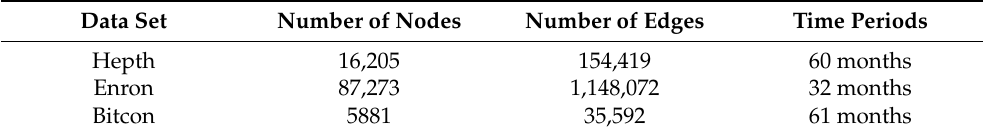
Table 5. Description Of The Data